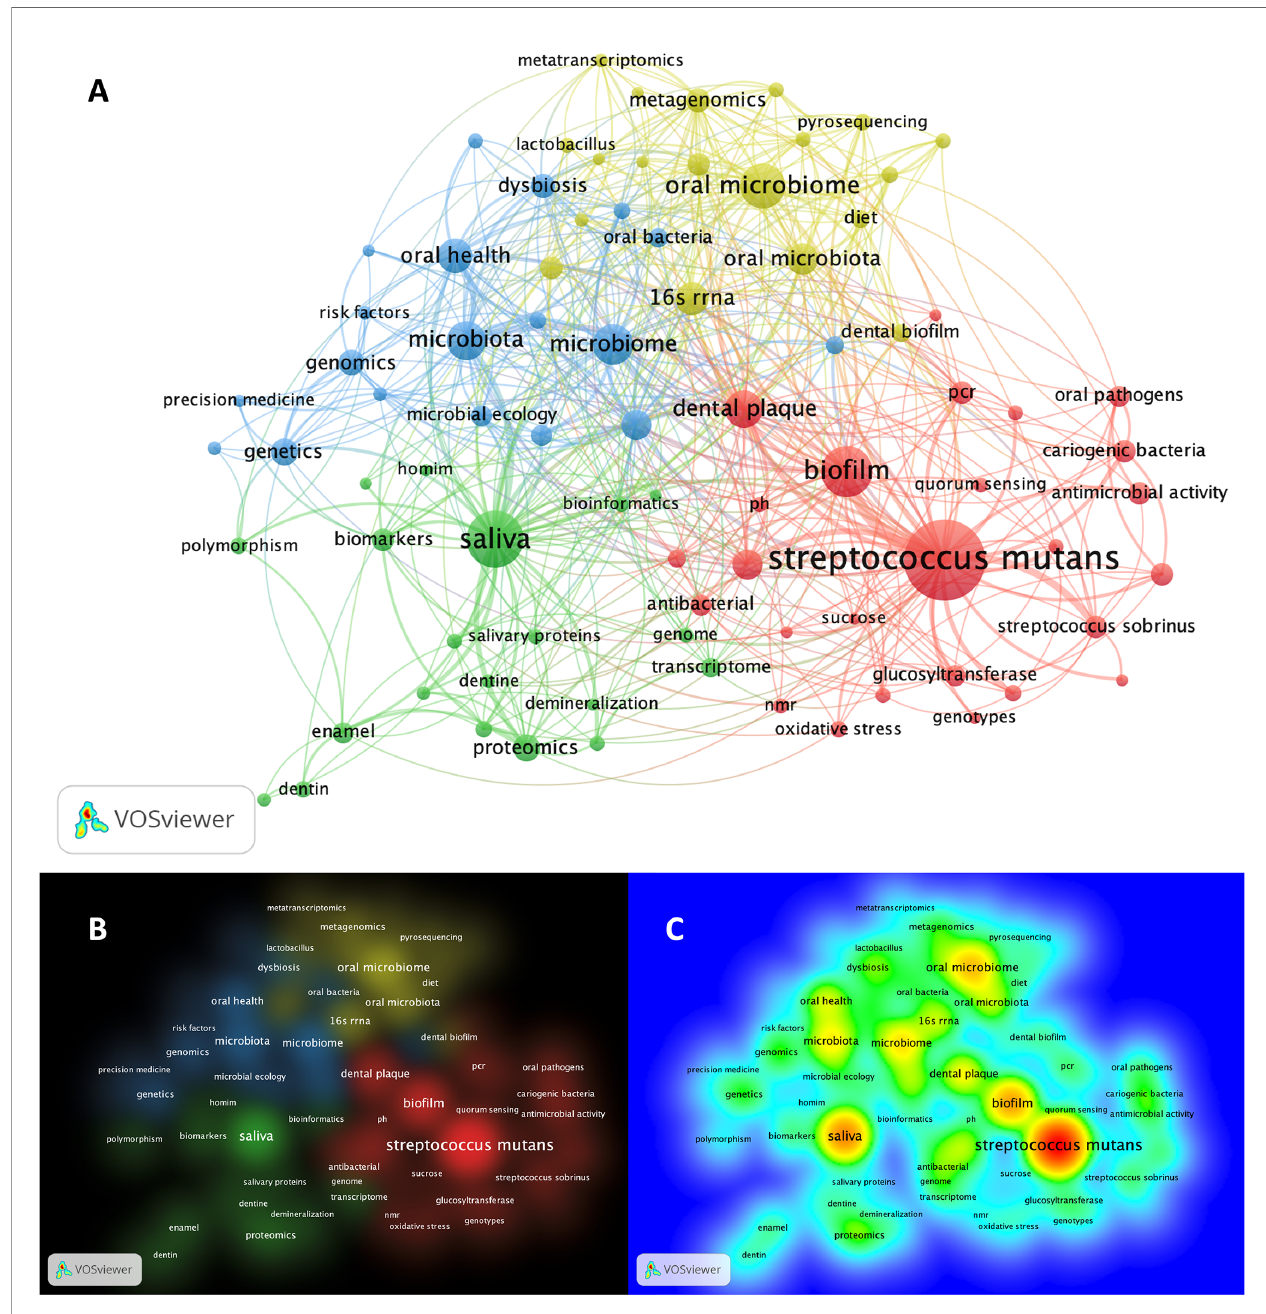
FIGURE 4 | Bibliographic mapping of keywords associated with omic-related publications in dental caries research. (A) Mapping of keywords categorized cluster- based. The size of the nodes represents the frequency of keywords (larger nodes indicating higher frequency) and the distance between two terms, represent the strength of association between the terms (the smaller the distance, the higher the number of co-occurrences). Clusters are color-coded according to how relevant they appeared for the average number of times (threshold ≥ 6). (B) Pictograph representation of the keyword mapping showing the cluster density of the identi fi ed 4 clusters. Representative keywords form each clusters are listed as follow: Cluster-1 ( red ): streptococcus mutans , oral streptococci , oral pathogens, streptococcus sobrinus , sucrose, pH, sever early childhood caries, quorum sensing, PCR, oxidative stress, acid tolerance, antibacterial, antimicrobial activity, bio fi lm, bio fi lm formation, cariogenic bacteria, dental plaque, genotype, genotypes, glucosyltransferase; Cluster-2 (green) : saliva, salivary proteins, proteome, proteomics, transcriptome, metabolome, mass spectrometry, genome, homim, homings, biomarkers, polymorphism, bioinformatics, hydroxyapatite, enamel, dentin, demineralization; Cluster-3 (blue) : genetics, genomics, risk factors, precision medicine, microbial ecology, epidemiology, microbiome, dysbiosis, microbiota, oral health; Cluster-4 (yellow) : 16S rRNA, 16S rRNA gene sequencing, high-throughput sequencing, metagenomics, metabolomics, metatranscriptomics, next generation sequencing, pyrosequencing, machine learning. (C) Pictograph representation of the keyword mapping categorized frequency-based showing the item density. The brighter the node, the more frequently used keyword. For example, streptcoccus mutans , saliva, bio fi lm and microbiome show the highest density (frequency), respectively where the precision medicine and metatranscriptomics show the lowest density within the setting of the shown